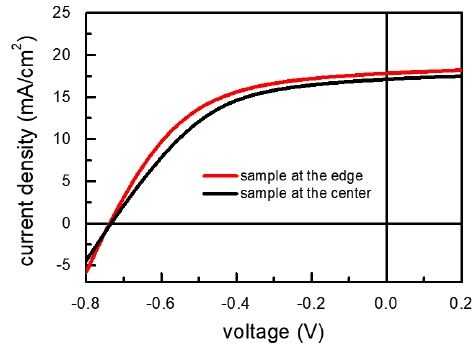
Figure 5. ( a ) Thickness deviation and ( b ) thickness ratio of silver nanowire flexible electrodes embedded in different NOAs.